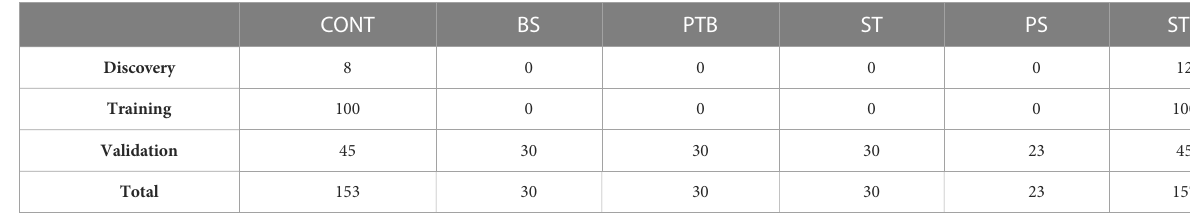
TABLE 1 Study population